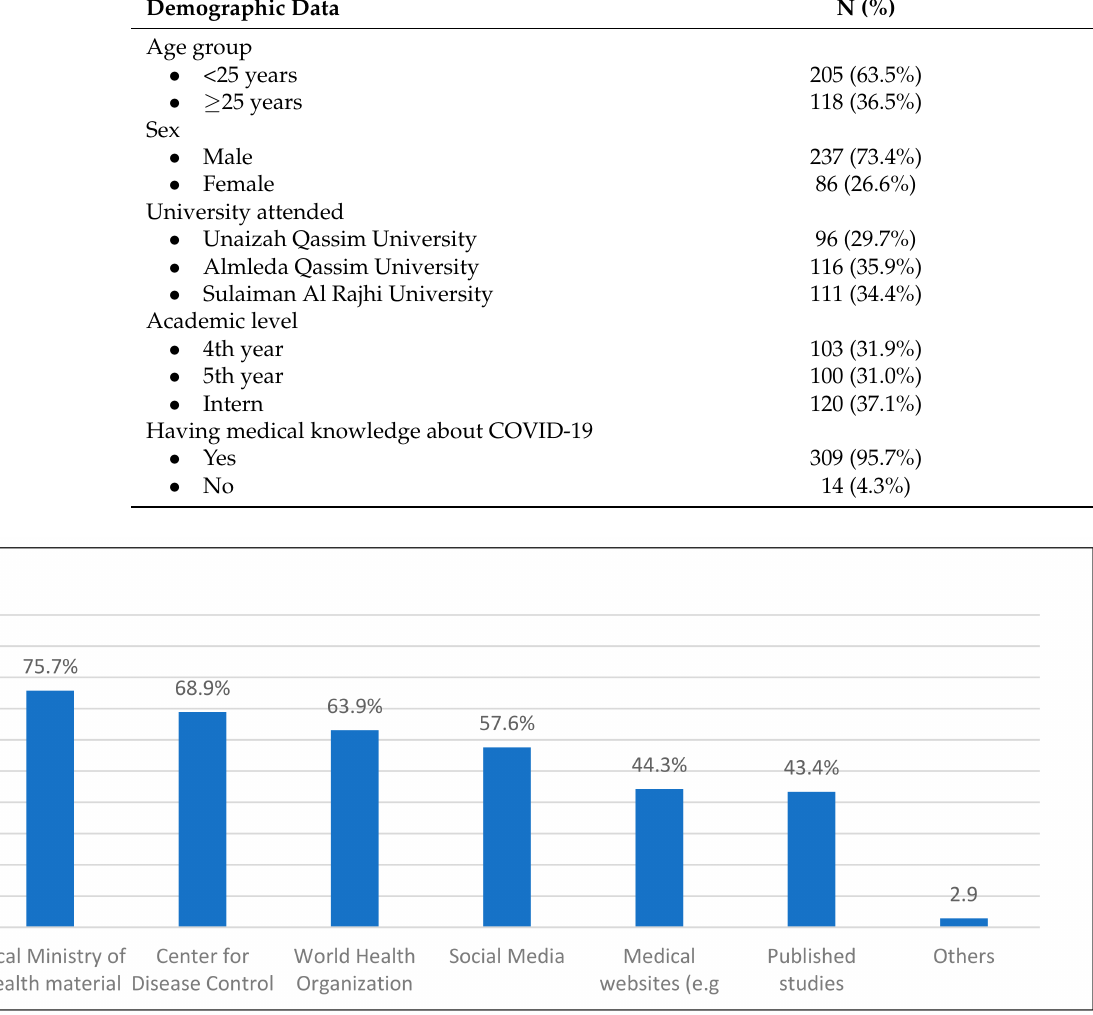
Figure 1. Sources of COVID-19